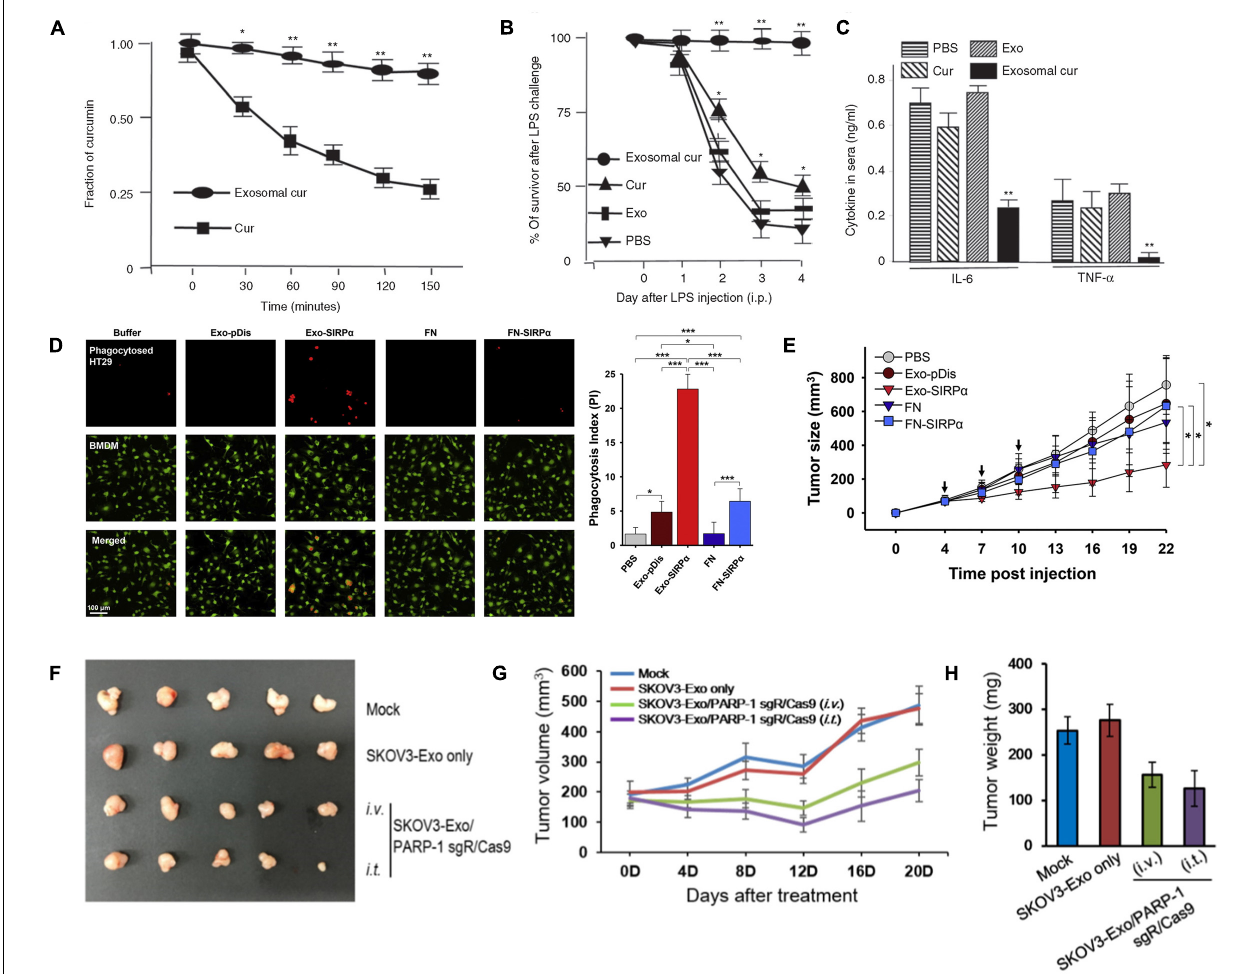
FIGURE 2 | (A–C) Curcumin encapsulated in exosomes improved the bioavailability after intraperitoneal injection (A) ; exosomal curcumin reduced lung inflammation (B) and increased survival (C) of lipopolysaccharide-induced septic shock mice. (D,E) Exosome containing SIRP α (Exo-SIRP α ) enhanced phagocytosis of HT29 cells by bone marrow derived macrophages (BMDMs) (D) and in vivo antitumor efficacy (E) . (F–H) Exosomes loaded with PARP-1 sgR/Cas9 reduced tumor size (F,G) and weight (H) on SKOV3 xenograft mice after intravenous or intratumoral injection (* p < 0.05, ** p < 0.01 and *** P < 0.0001). Figure reprinted from Sun et